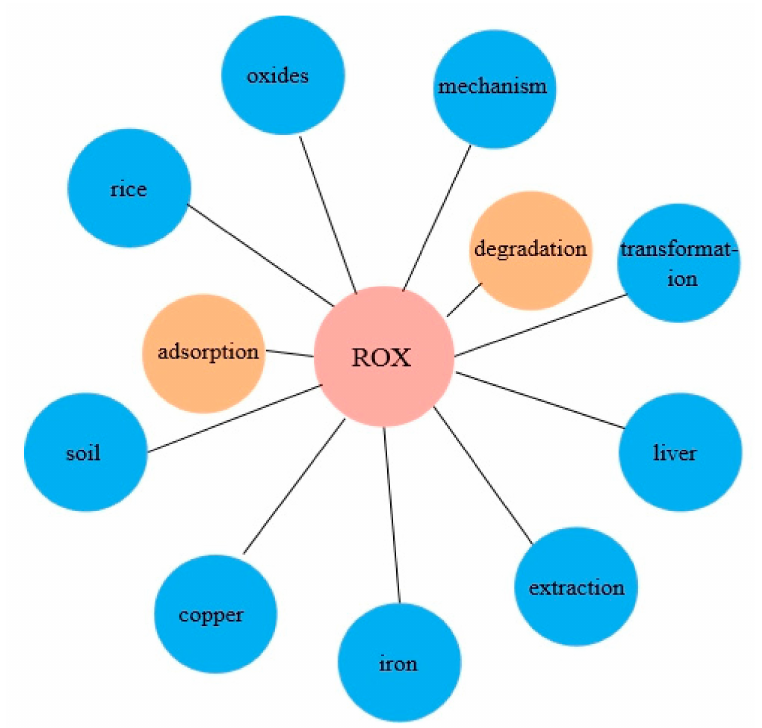
Figure 2. The correlation diagram between ROX and keywords. The yellow circles indicate frequent occurrences, and the blue circles indicate rare